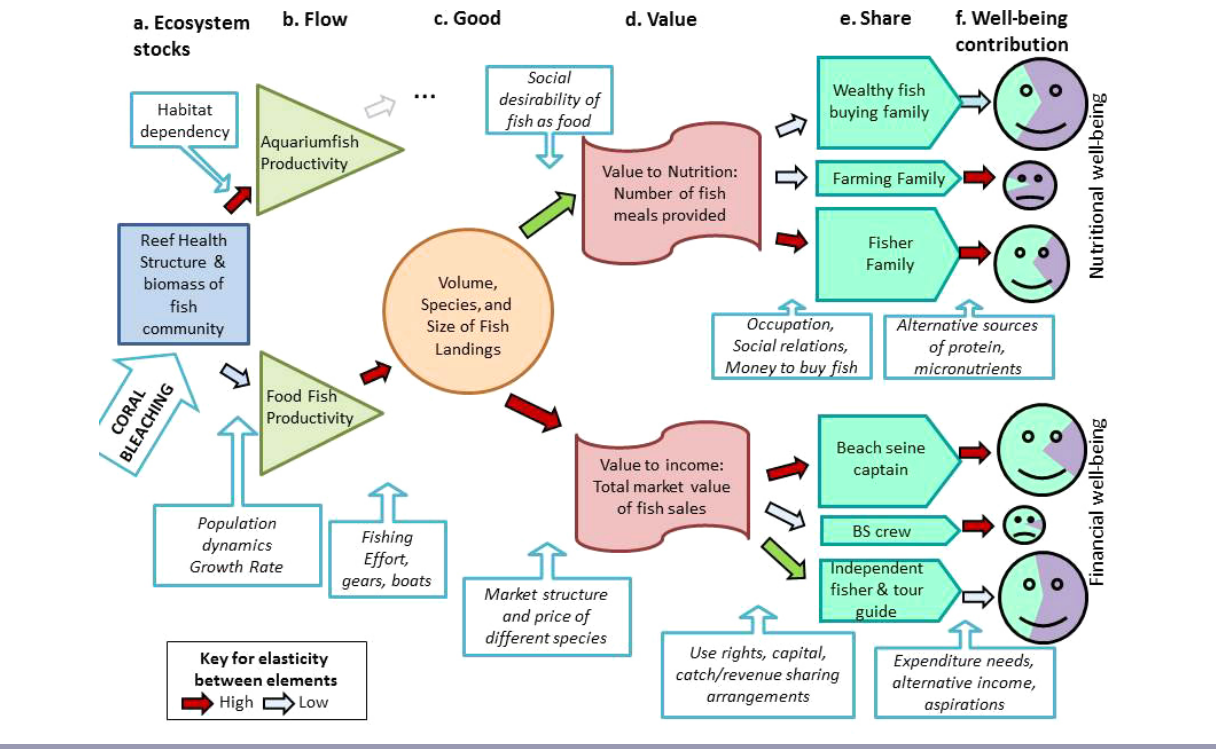
Fig. 4 . The branching of an ecosystem services-well-being chain by consideration of multiple flows from a given stock, multiple values of a good, and multiple groups of people receiving different shares of that value that contributes to each’s well-being dependent on their needs, gaps, and aspirations. The aquarium fish chain is only illustrated as far as the flow. Arrows between each element highlight high or low elasticity between elements along the chain.